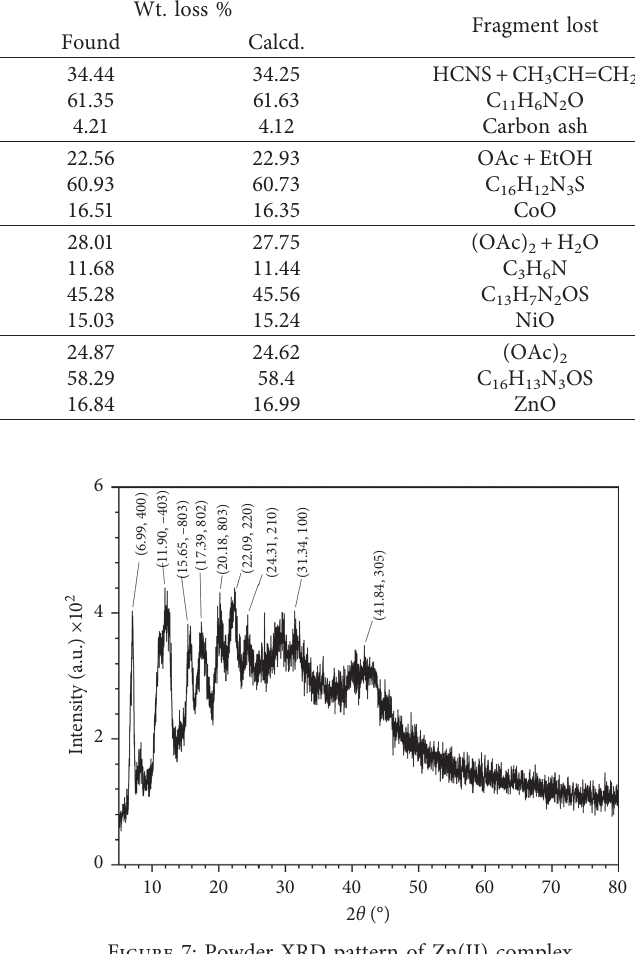
Figure 7: Powder XRD pattern of Zn(II)